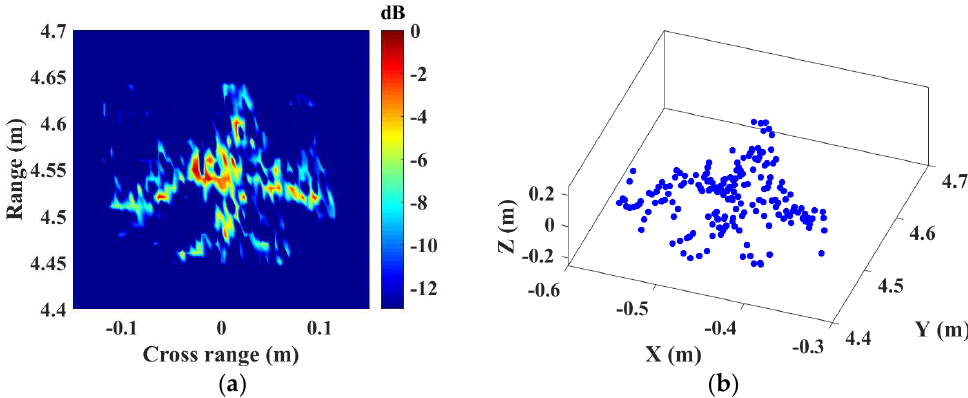
Figure 12. ISAR and InISAR imaging results of the moving target in the left window. ( a ) 2D ISAR image, ( b ) 3D InISAR image.